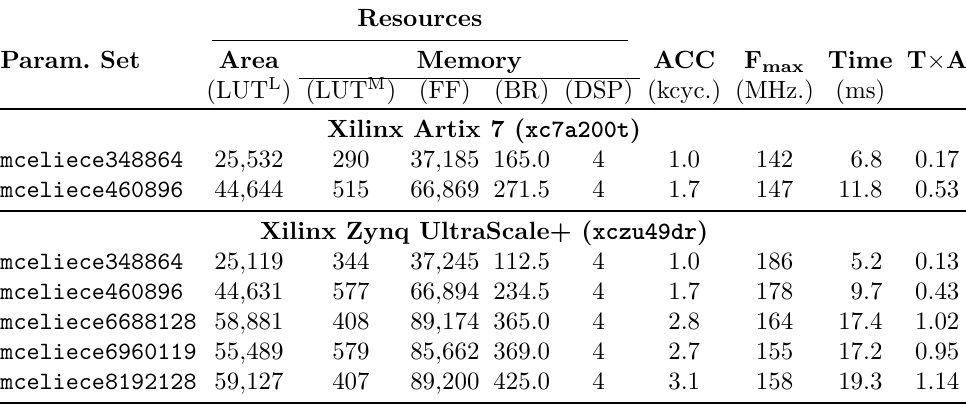
Table 6: Comparison of the time and area for our SeededKeyGen module targeting Xilinx Artix 7 ( xc7a200t ) and Xilinx Zynq UltraScale+ ( xczu49dr ) FPGAs. Resources Param.